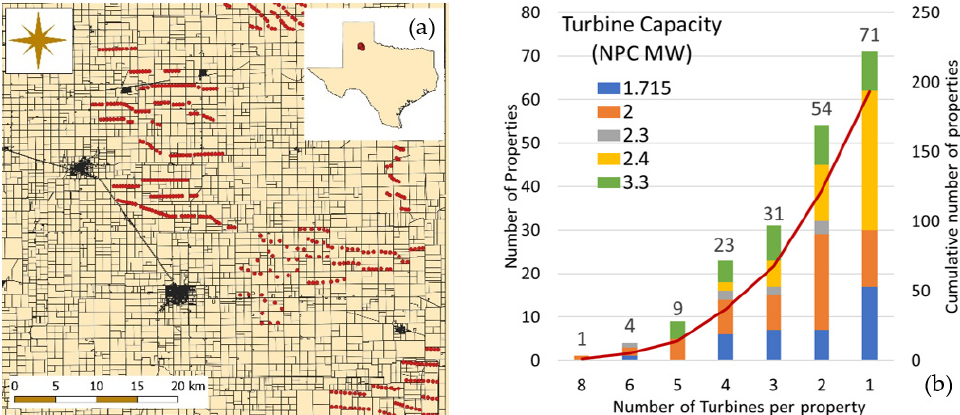
Figure 12. Assessment for wind turbine placement on individual lots applying data from Floyd County (Texas). ( a ) Shapefile for individual parcels with corresponding turbines represented as red points overlaid over each individual parcel. ( b ) Number of properties with turbines categorized number of turbines per property classified according to the Name Place Capacity (NPC) of the turbines with cumulative number of properties represented in the secondary y -axis.